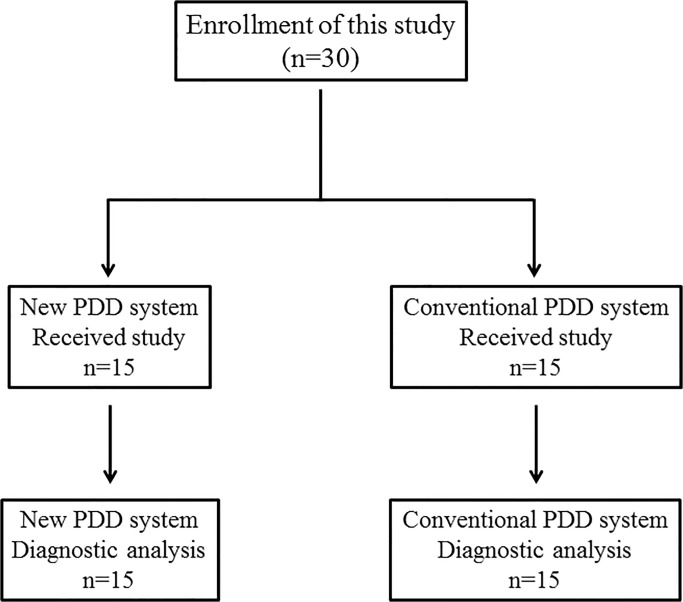
Flow chart of this study on new PDD system and conventional PDD system in the diagnosis of bladder cancer